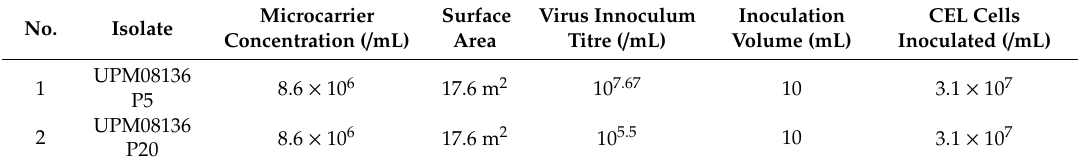
Microcarrier concentration, virus titer, and CEL cells volume used for the bioreactor